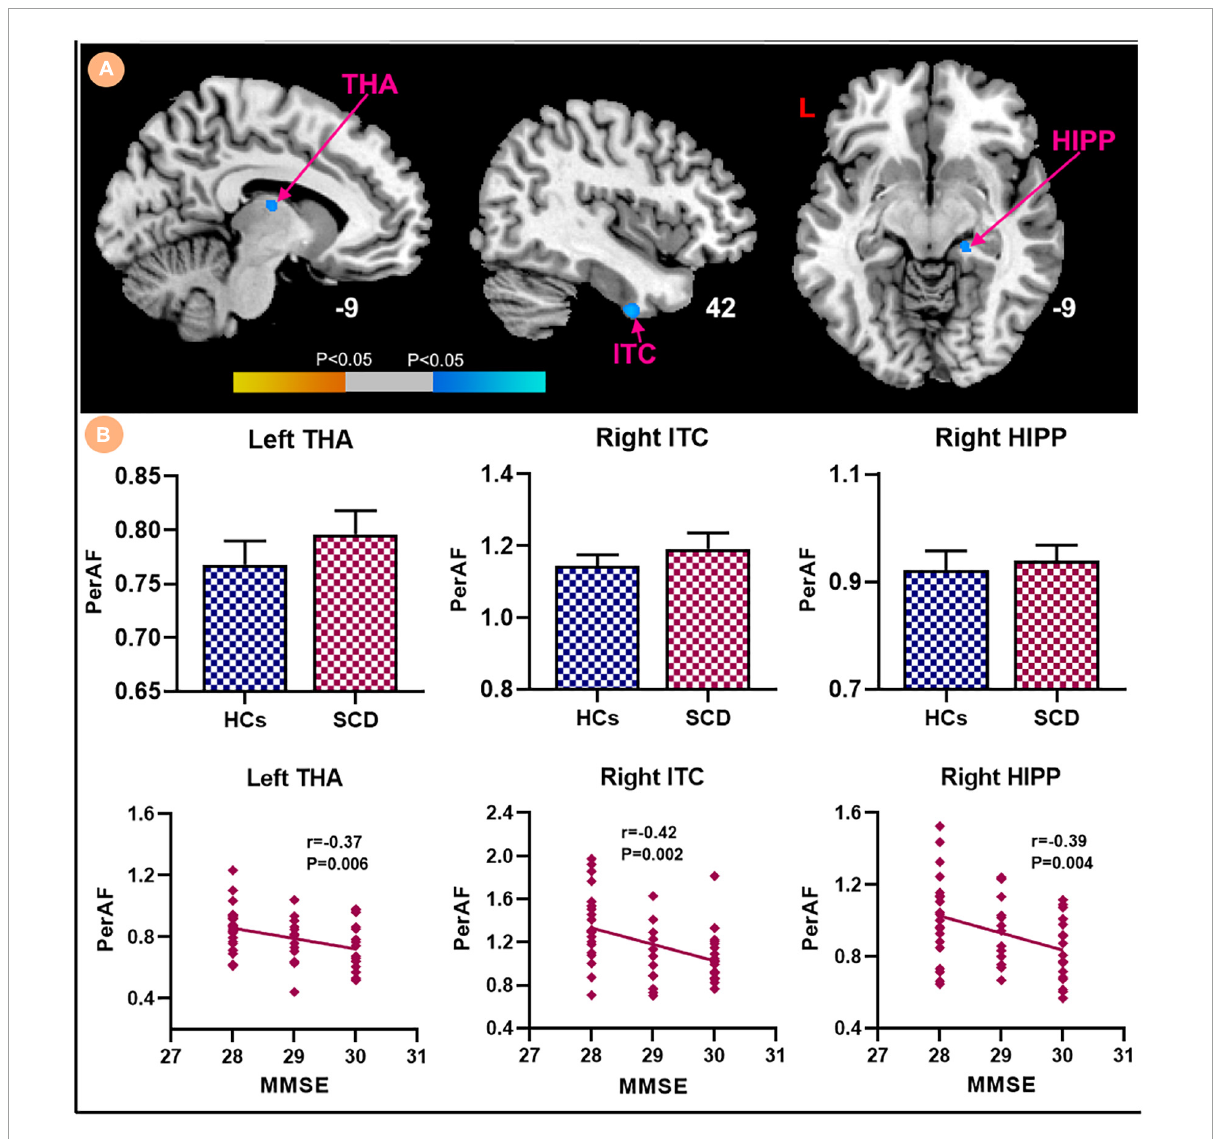
FIGURE2 Relationships between the PerAF and MMSE in subjective cognitive decline (SCD) patients. (A) PerAF covarying with MMSE in patiens with SCDs. Brain regions marked by warm color represent positive correlation and brain regions marked by cool color represent negative correlation. (B) Extracted PerAF values and negative correlations between the MMSE and brain regions including the left THA, right ITC and right HIPP [mean ± standard error of mean